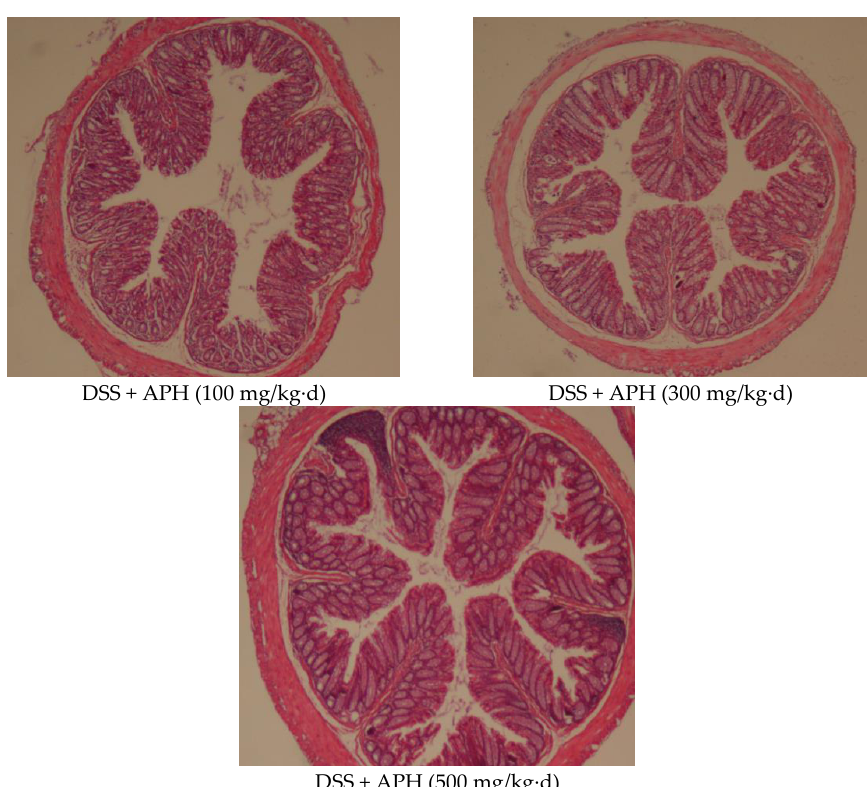
Figure 2. APH alleviates DSS-induced histopathological changes.